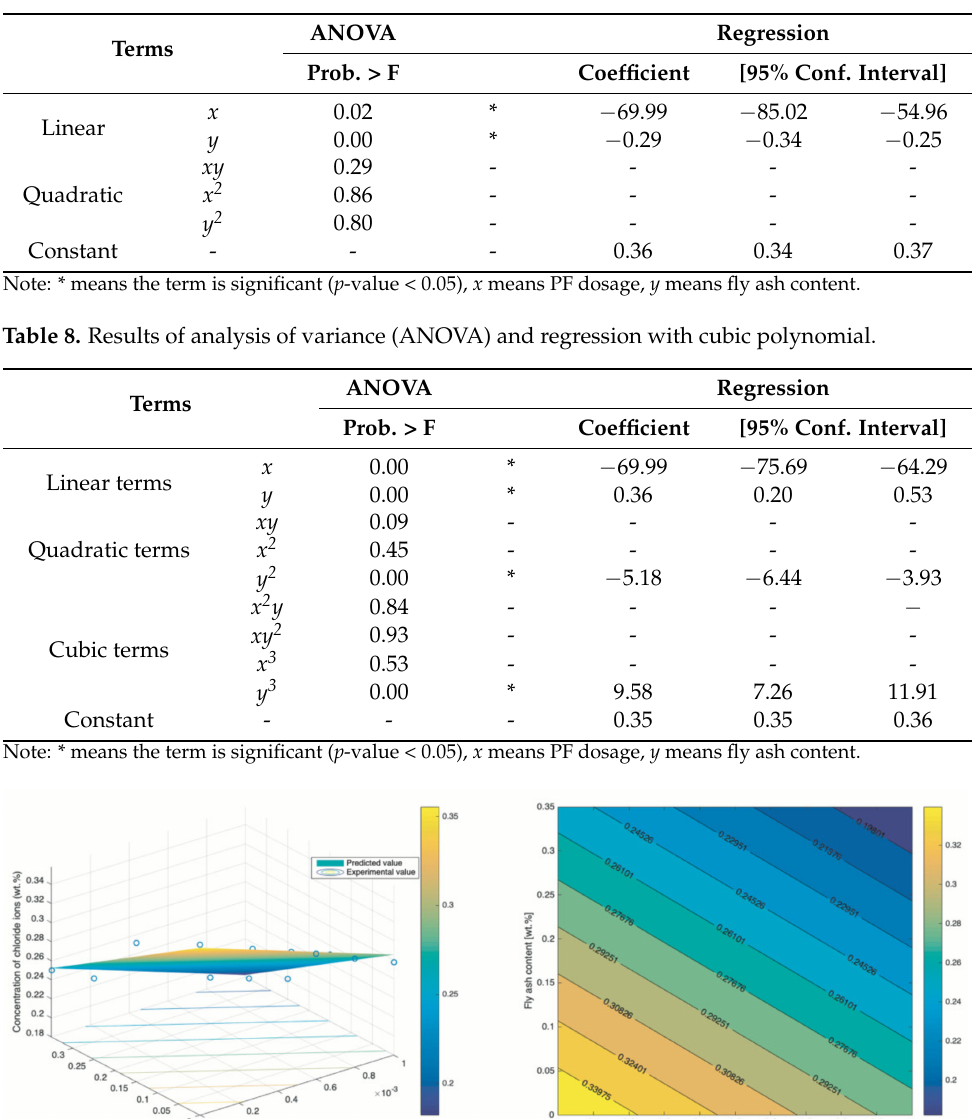
Table 7. Results of analysis of variance (ANOVA) and regression with quadratic polynomial.